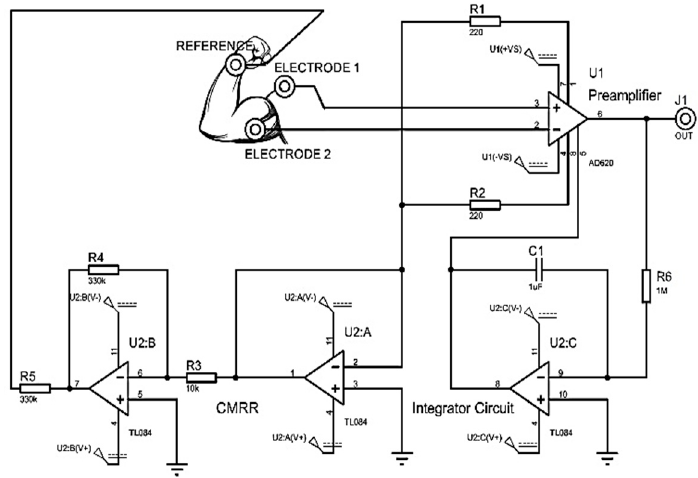
Figure 4. Amplification module and basal corrector.